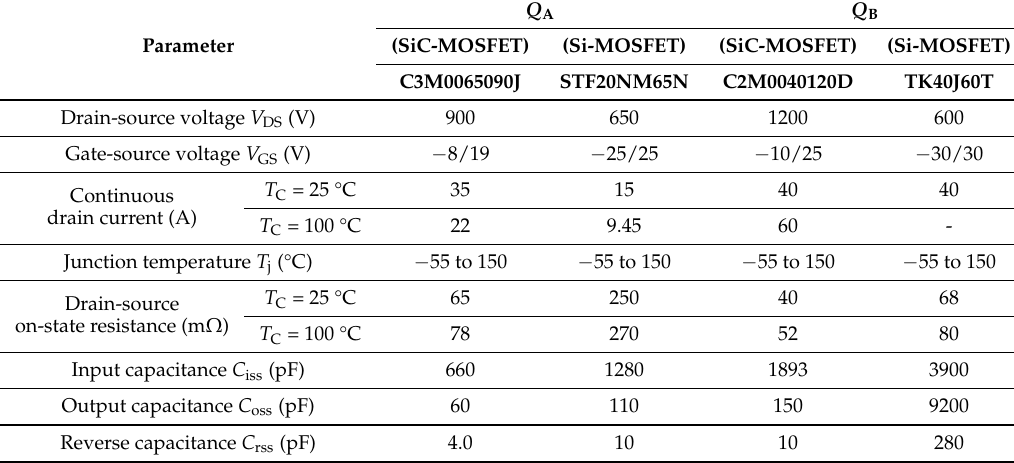
Table 2. Si- and SiC-metal-oxide-semiconductor field-effect transistors (MOSFETs) parameters in the experimental setup.